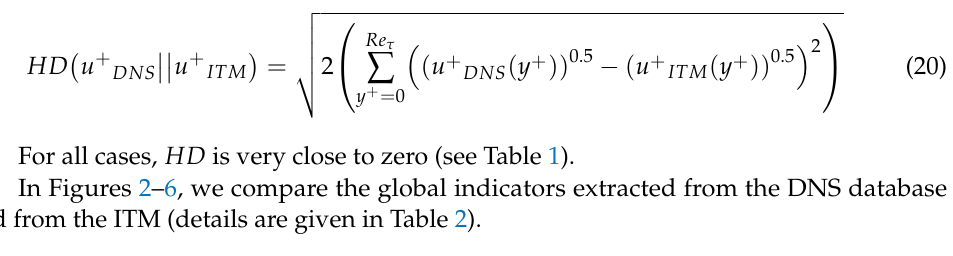
and of the centerline velocity 𝑏𝑏+ 𝑈𝑈